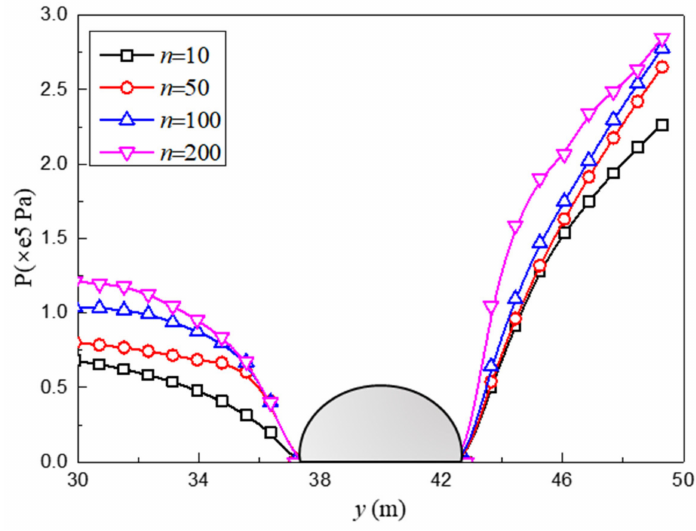
Figure 11. Water pressure distribution of tunnel rock at [30, 50] range under different fracture numbers.